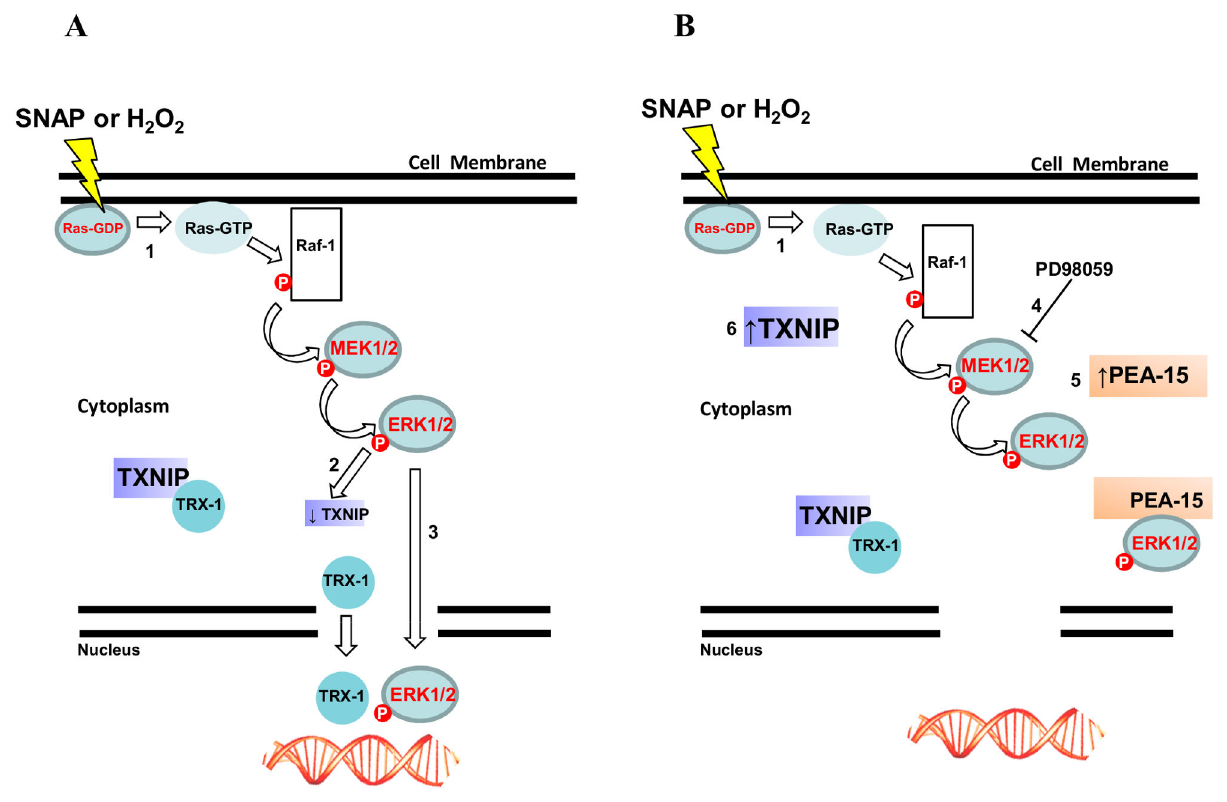
Figure 9. Schematic representation of TRX-1 and the ERK1/2 MAP kinases nuclear translocation stimulated by nitrosative/ oxidative stress conditions. (A) The Ras-Raf-MEK-ERK 1/2 signaling pathway is activated in HeLa wild-type cells after exposure to 0.5 mM SNAP or 0.5 mM H O (1). Under these conditions expression of TXNIP is down-regulated at mRNA and protein levels 2 2 (2) and TRX-1 and the ERK 1/2 MAP kinases, independently of each other, migrate to the nuclear compartment (3). (B) Nuclear migration of TRX-1 and the ERK 1/2 MAP kinases is prevented in three situations: HeLa cells pre-incubated with the MEK inhibitor PD98059 (4), HeLa cells over-expressing the cytoplasmic anchor of ERK 1/2 MAP kinases – PEA-15 (5), HeLa cells over- expressing the physiological inhibitor of TRX-1, TXNIP